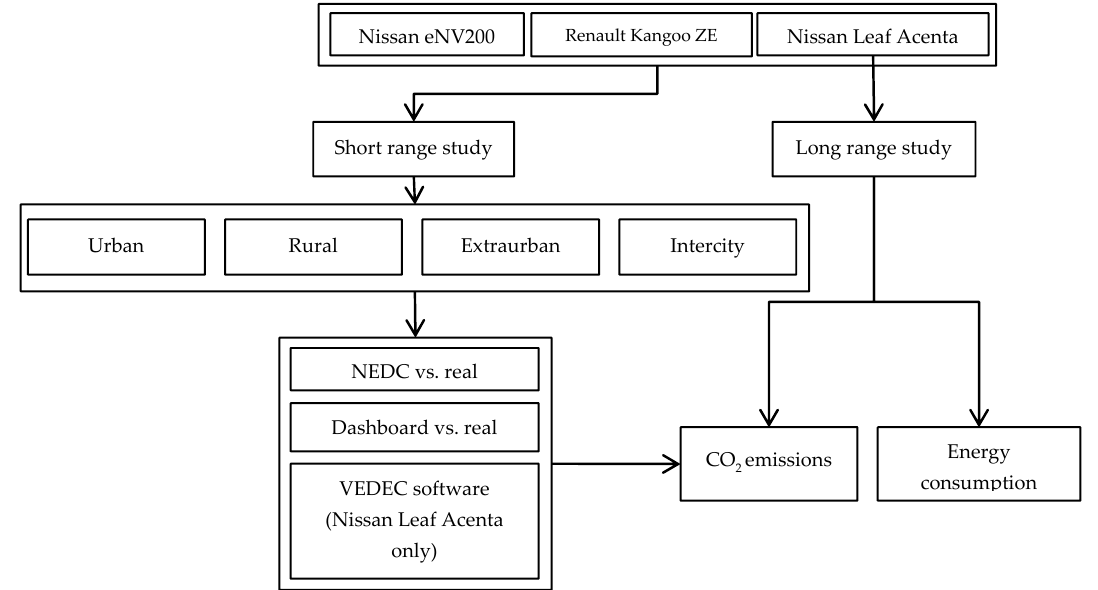
Figure 1. Flowchart illustrating the main steps of the adopted Figure 1 : F lowchart illustrating the main steps of the adopted methodology 211